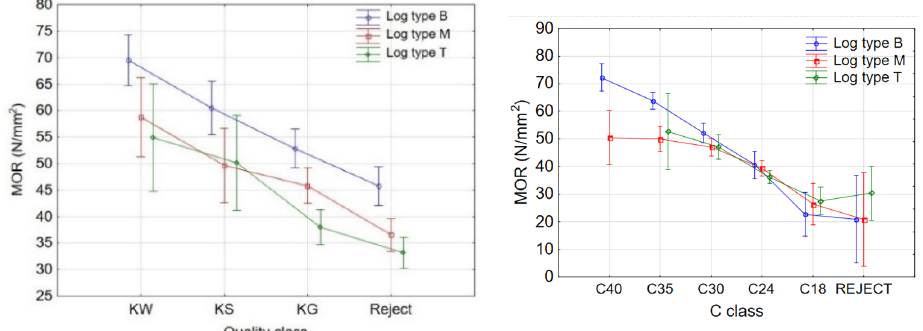
Figure 4. MOR distribution in relation to timber quality.